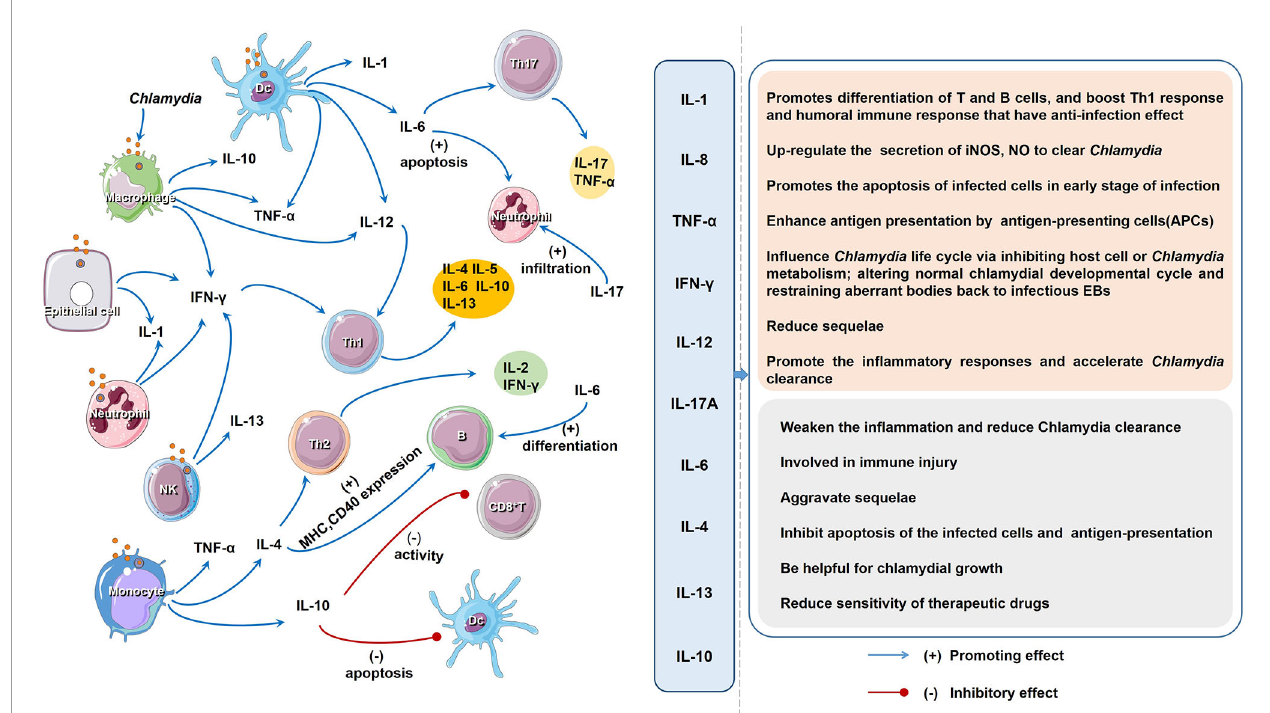
FIGURE 2 | The regulatory network and function of different cytokines upon Chlamydia infection. The host cells produce a variety of cytokines after chlamydial infection. Cytokines induce cell immunity response and produce more cytokines. As descripted in text, the impact of all the cytokines on the host chlamydial infection can be divided into two aspects: favorable and